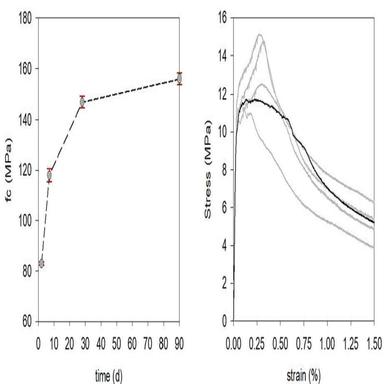
a) compressive strength evolution of UHPFRC-3 % (cubes 50 mm); b) Uniaxial tensile behaviour at 28 days in dog bone specimens).